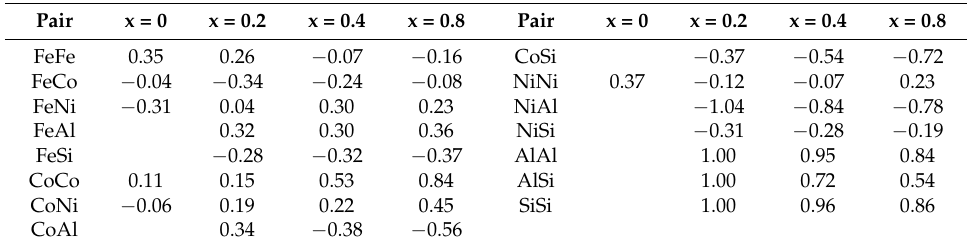
Table 2. Short-range order (SRO) parameters of the FeCoNi (AlSi) x alloys as a function of Al and Si fraction x.